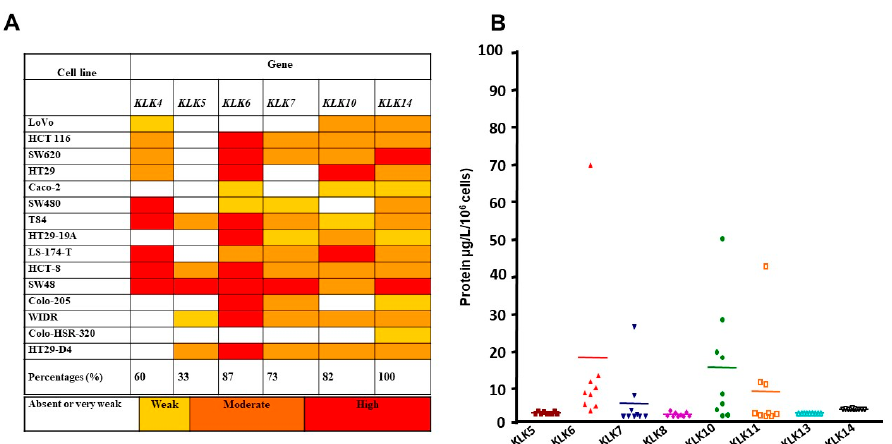
Figure 1. Analysis of the mRNA and protein expression pattern of KLK4, 5, 6, 7, and 14 in different colon cancer cell lines. ( A ) Analysis of KLK mRNA expression levels in the indicated human colon cancer cell lines by semiquantitative RT ‐ PCR. ( B ) Secretion of KLK 4, 5, 6, 7, 8, 10, 13, and 14 in conditioned medium from nine colon cancer cell lines was assessed by ELISA and is presented in a scatter plot. The protein levels are shown as the mean concentration of KLKs ( μ g/L) secreted by 10 6 cells per 24 h. Median values are marked with a horizontal line.